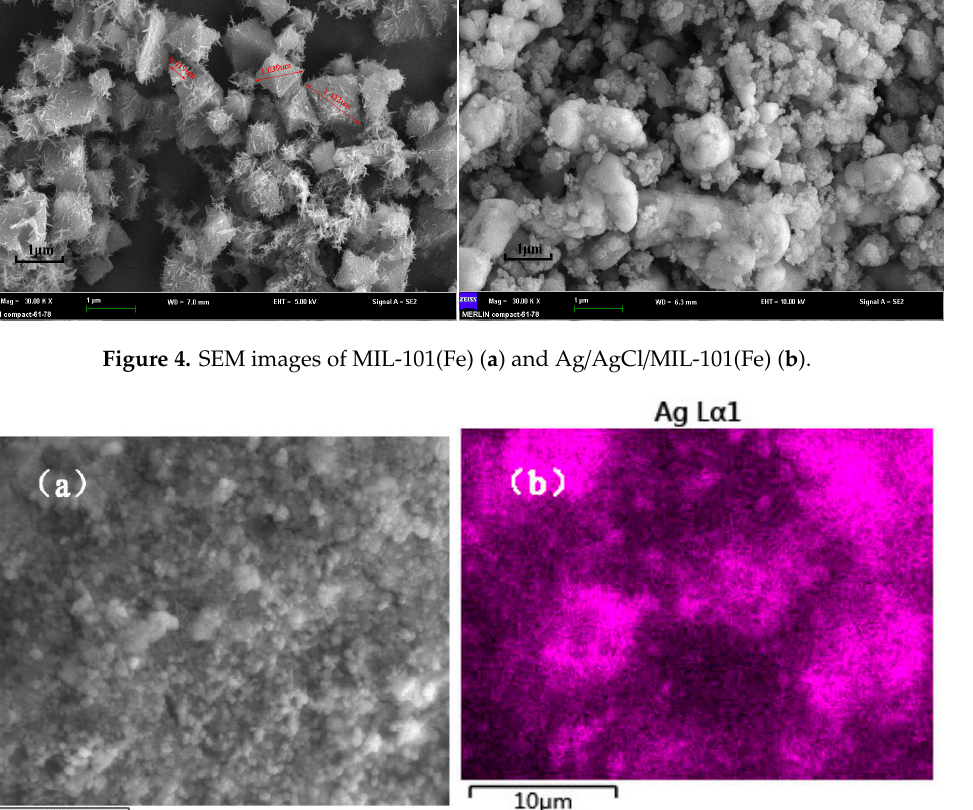
Figure 4. SEM images of MIL ‐ 101(Fe) ( a ) and Ag/AgCl/MIL ‐ 101(Fe) ( b ).